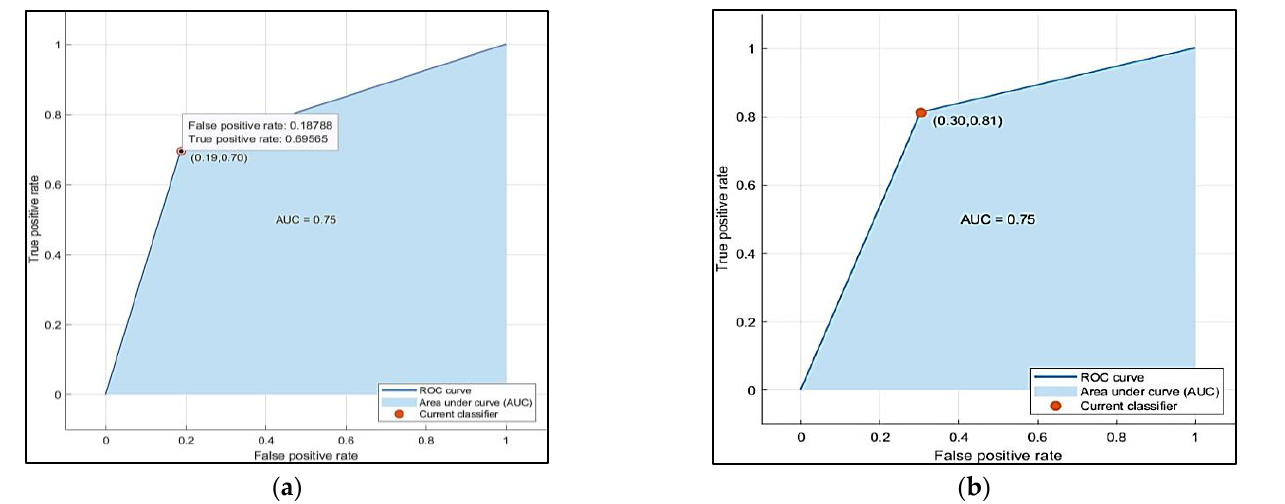
Figure 10. ( a ) ROC curve corresponding to class 0 using the SVM ( b ) ROC curve corresponding to class 1 using the SVM.